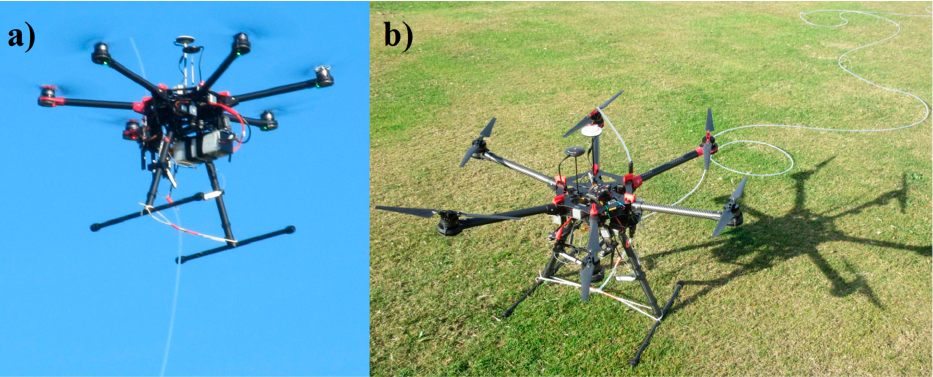
Figure A1. ( a ) The DJI Spreading Wings S900 UAV, mid-flight, with a 150 m long tether, connected to an instrument on the ground; ( b ) The UAV on the ground, prior to flight. Notice the air inlet above the plane of the